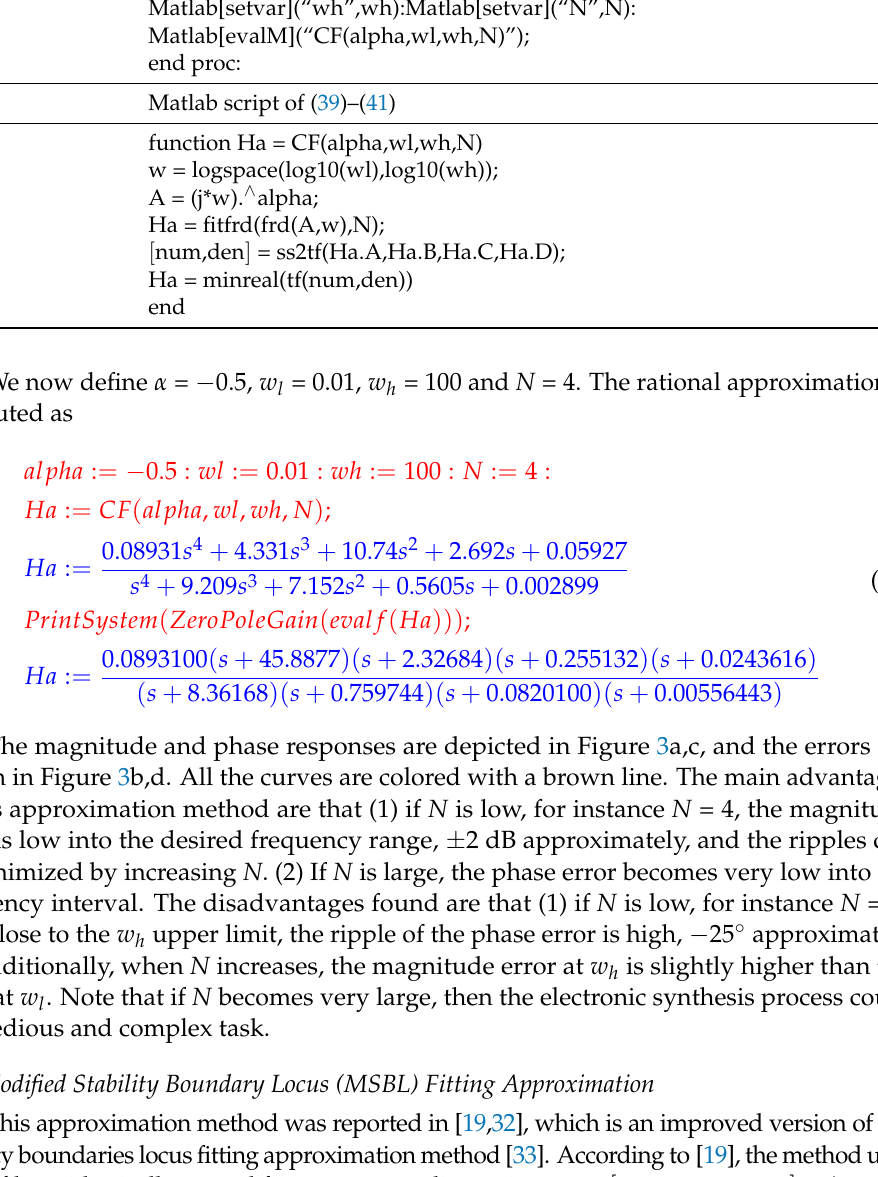
Table 13. Code in Maple 18 environment to call the m-file and Matlab script. CF :=